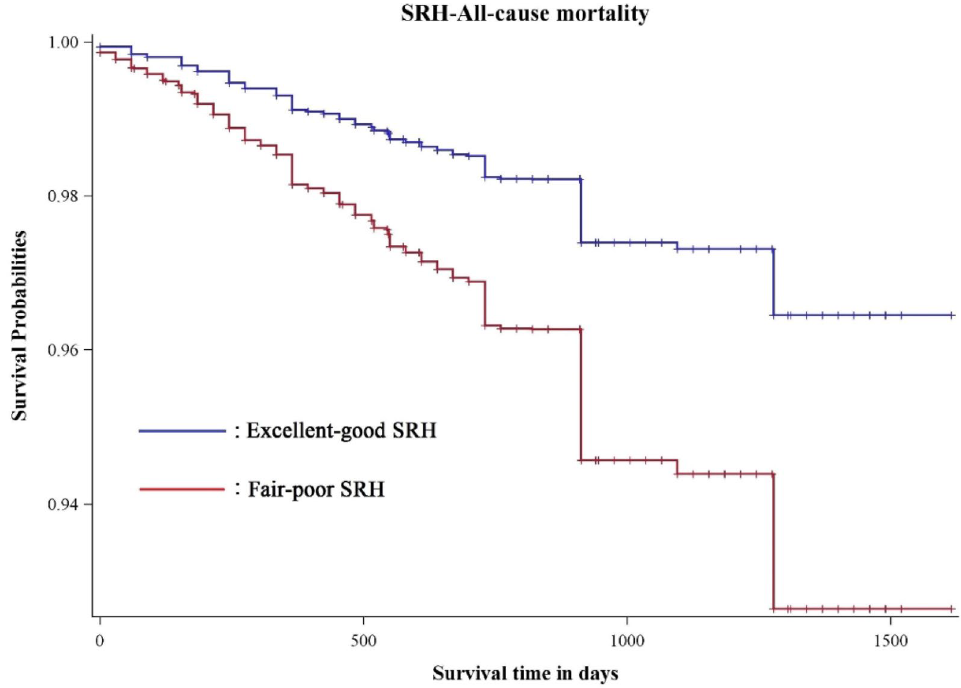
Figure 2. Kaplan–Meier curves for the cumulative risk of mortality by SRH levels.